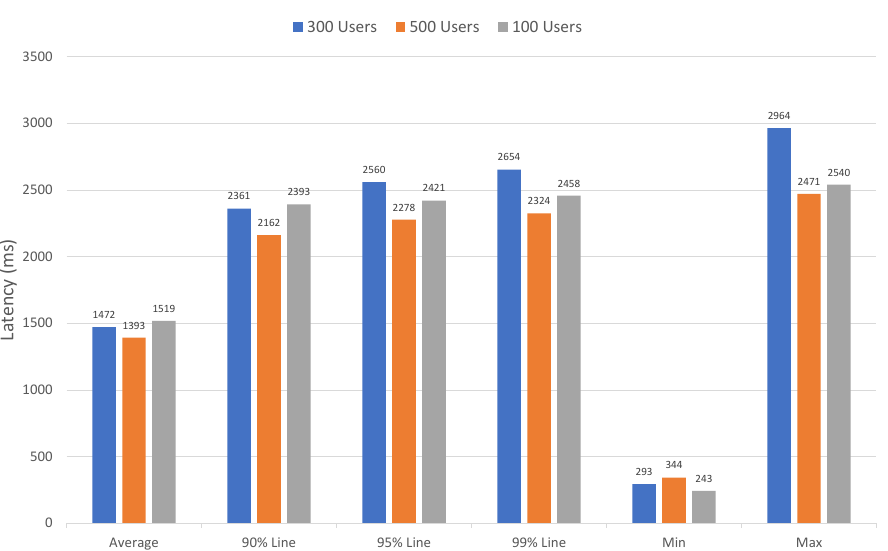
Figure 29. Latency in invoking transaction (Post